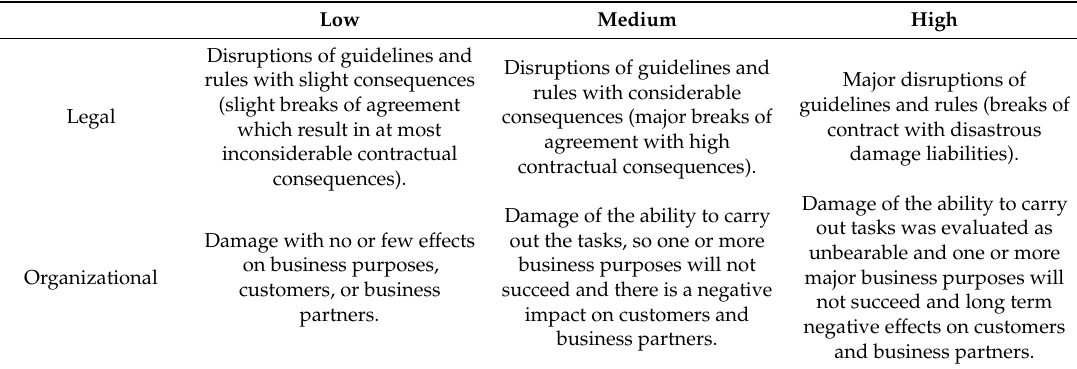
Table 1. Damage areas and categories: